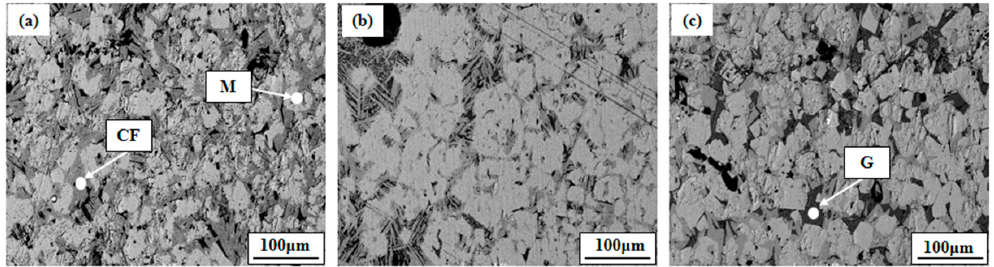
Figure 6. The SEM image of the different MgO content sinter ( a ): 1.3 wt%; ( b ): 1.7 wt%; ( c ): 2.0 wt%. (M: magnesioferrite CF: calciumferrite G: glass phase.)